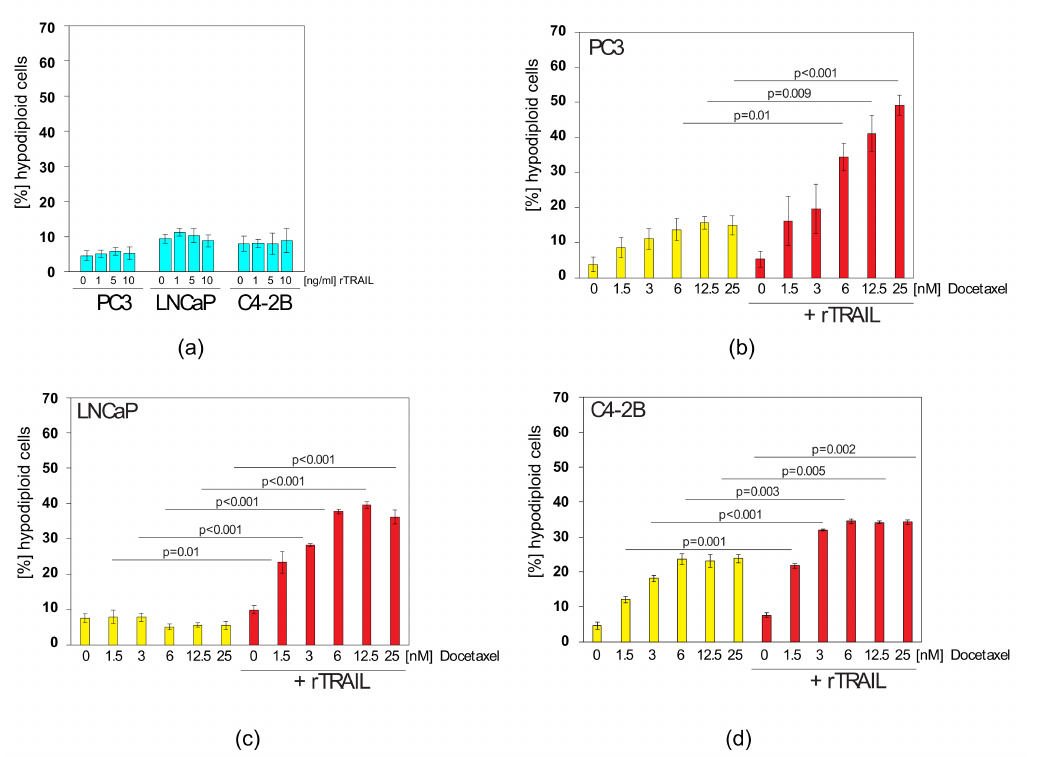
Figure 4. Docetaxel can sensitise TRAIL-resistant prostate cancer cells to the apoptosis-inducing e ff ects of TRAIL. ( a ) PC3, LNCaP and C4-2B cells were treated with increasing concentrations of rTRAIL before apoptosis was measured. ( b ) PC3 cells were treated with increasing concentrations of docetaxel as indicated or treated with docetaxel / TRAIL mixes. TRAIL was used at 5 ng / mL. ( c ) LNCaP cells were treated with increasing concentrations of docetaxel as indicated or treated with docetaxel / TRAIL mixes. TRAIL was used at 5 ng / mL. ( d ) C4-2B cells were treated with increasing concentrations of docetaxel as indicated or treated with docetaxel / TRAIL mixes. TRAIL was used at 5 ng / mL. Values represent mean ±